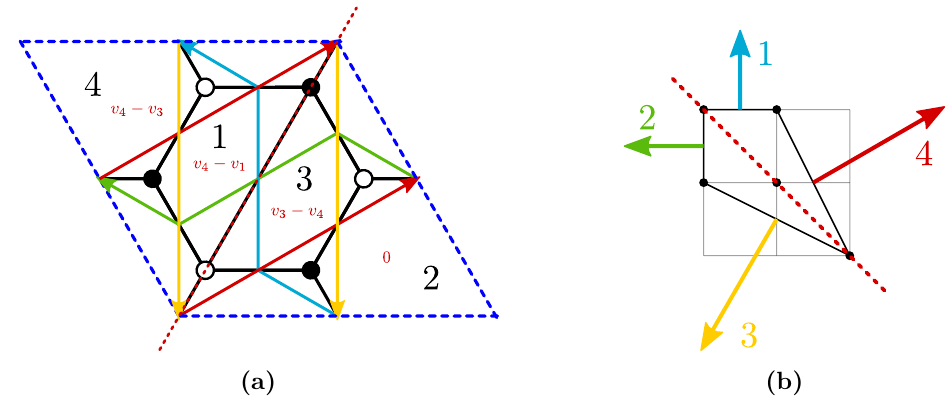
Figure 9. (a) Dimer diagram for dP 1 with a diagonal fixed line (dotted red). We show the ZZPs and the rank assignments coming from them. (b) The toric/web diagram with the corresponding symmetry